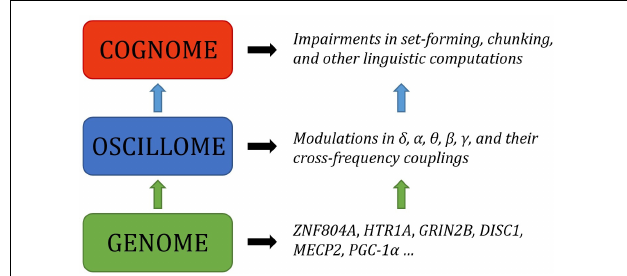
FIGURE 5 | Outline of a putative oscillogenomic model for the human faculty of language. ASD, SZ, SLI, and DD have been used as guiding ‘oscillopathies,’ whereas linguistic theory has been employed as a guide for the neurocomputational basis of language. The genome is expected to modulate frequency bands and their interactions at the level of the oscillome, which in turn impacts computational operations at the ‘cognome,’ that is, the basic cognitive operations underlying language, to use a term of Poeppel (2012). For instance, as noted in the text, knockout of Ppargc1a in mice decreases the spread of activation in hippocampal CA1 and limits pyramidal cell spiking, leading to unusual modulations of kainate-induced γ . PPARGC1A deficiency in ASD may consequently lead to direct oscillatory alterations at this frequency band; a hypothesis pending experimental confirmation.